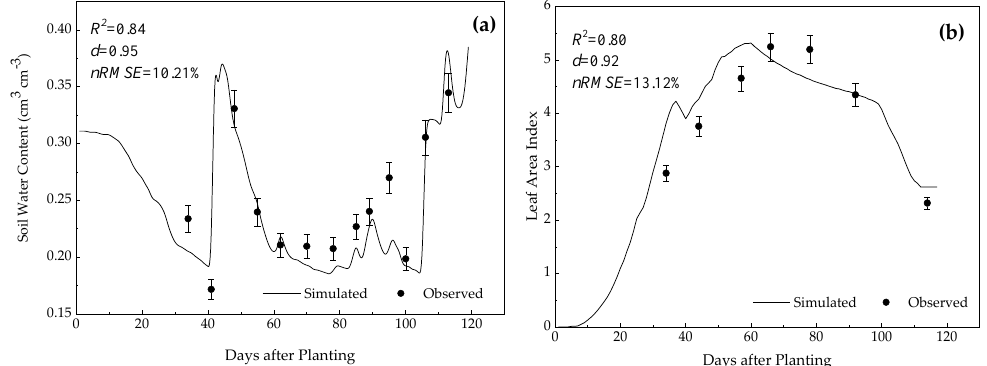
Figure 5. ( a ) Relationships between simulated and observed values of soil water content from 20–40 cm under treatment (irrigation: 60 mm; nitrogen: 150 kg hm − 2 ) at Wugong County; ( b ) relationships between simulated and observed leaf area index under treatment (irrigation: 60 mm; nitrogen: 150 kg hm − 2 ) at Wugong County.